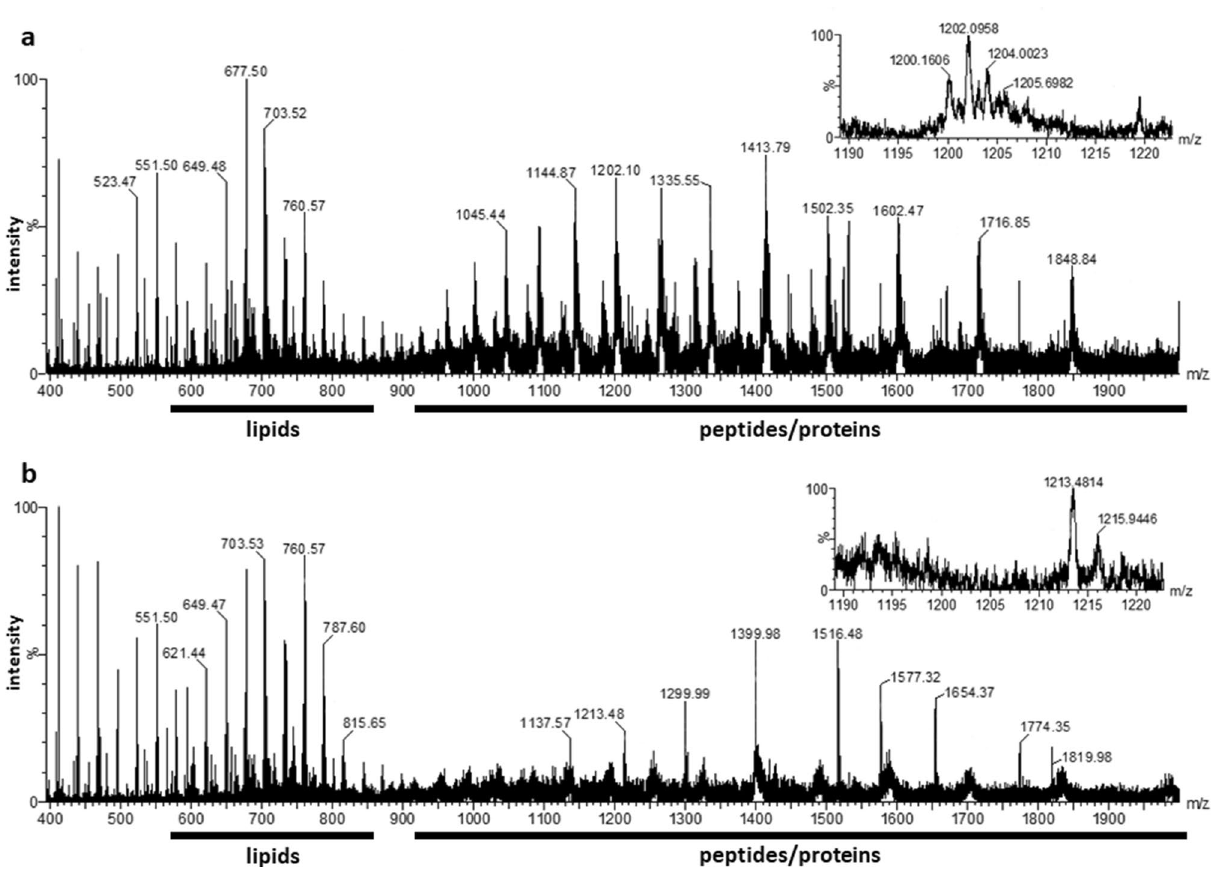
Figure 2. Liquid AP-MALDI mass spectra of cow milk ( a ) and goat milk ( b ), each acquired over 5